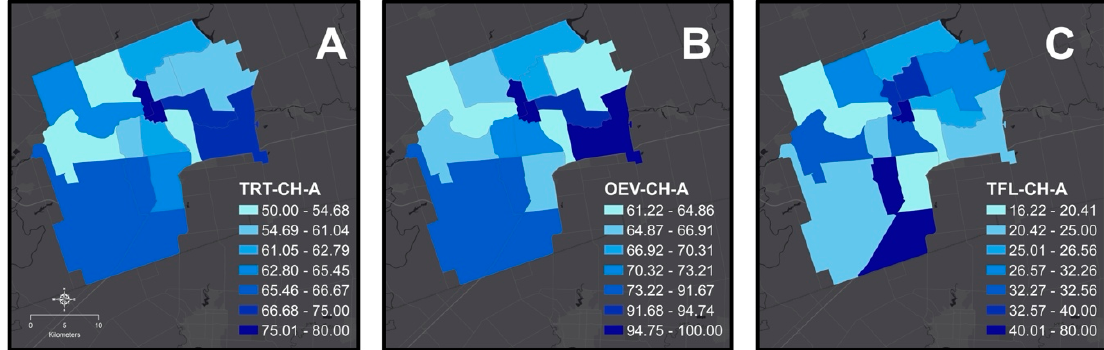
Figure 1. Geographic patterns of dental outcomes at FSA level: ( A ) Treatment received, ( B ) Visits to the dentist, and ( C ) Topical Fluoride Application.